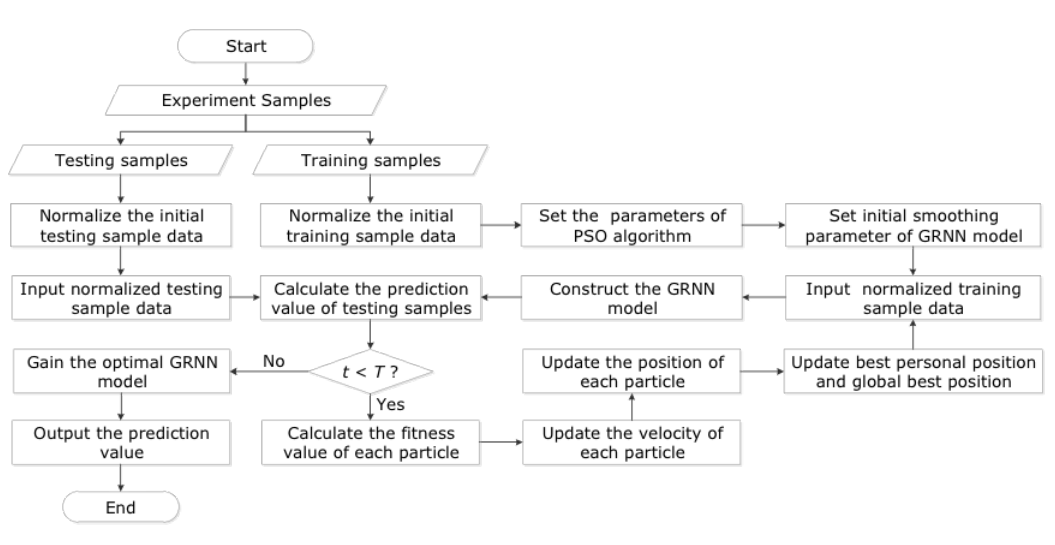
Figure 3. Solution process of PSO-GRNN